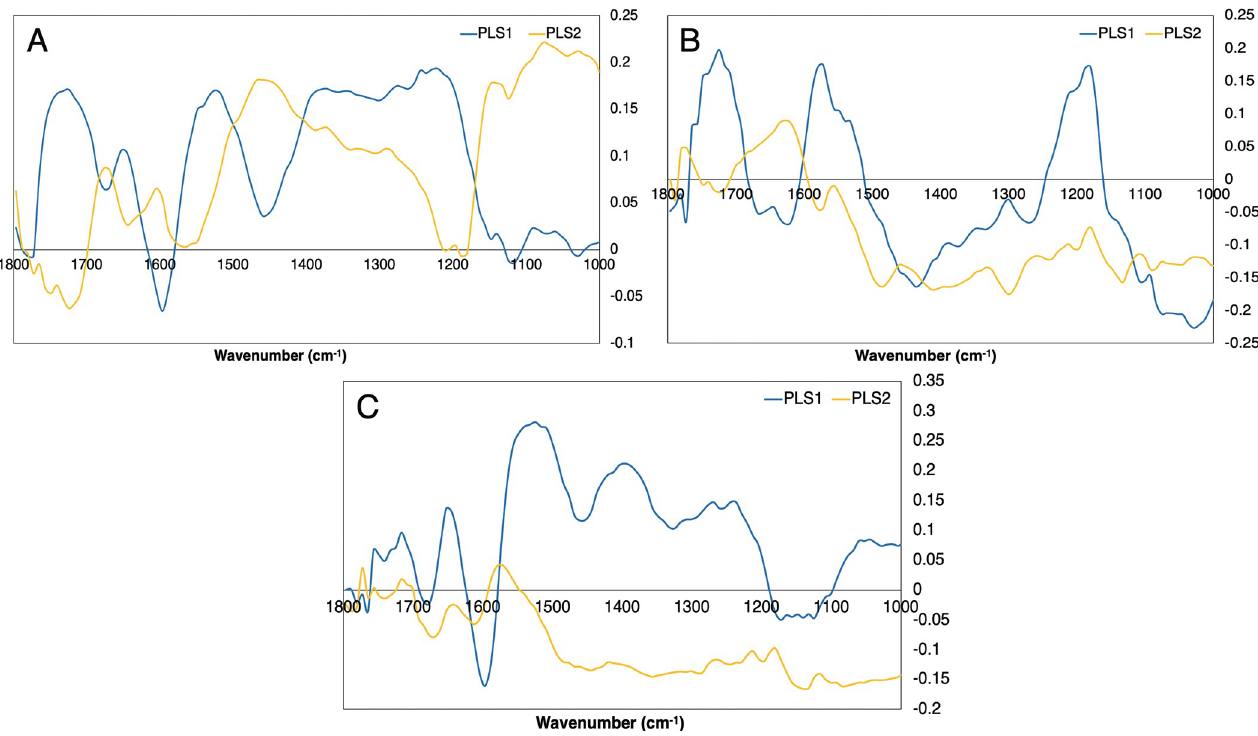
Fig 5. PLS loadings plot for the 1 st and 2 nd LVs for the filtered serum ( < 100 kDa). (A) GBM versus non-cancer, (B) Lymphoma versus non-cancer and (C) GBM versus lymphoma.